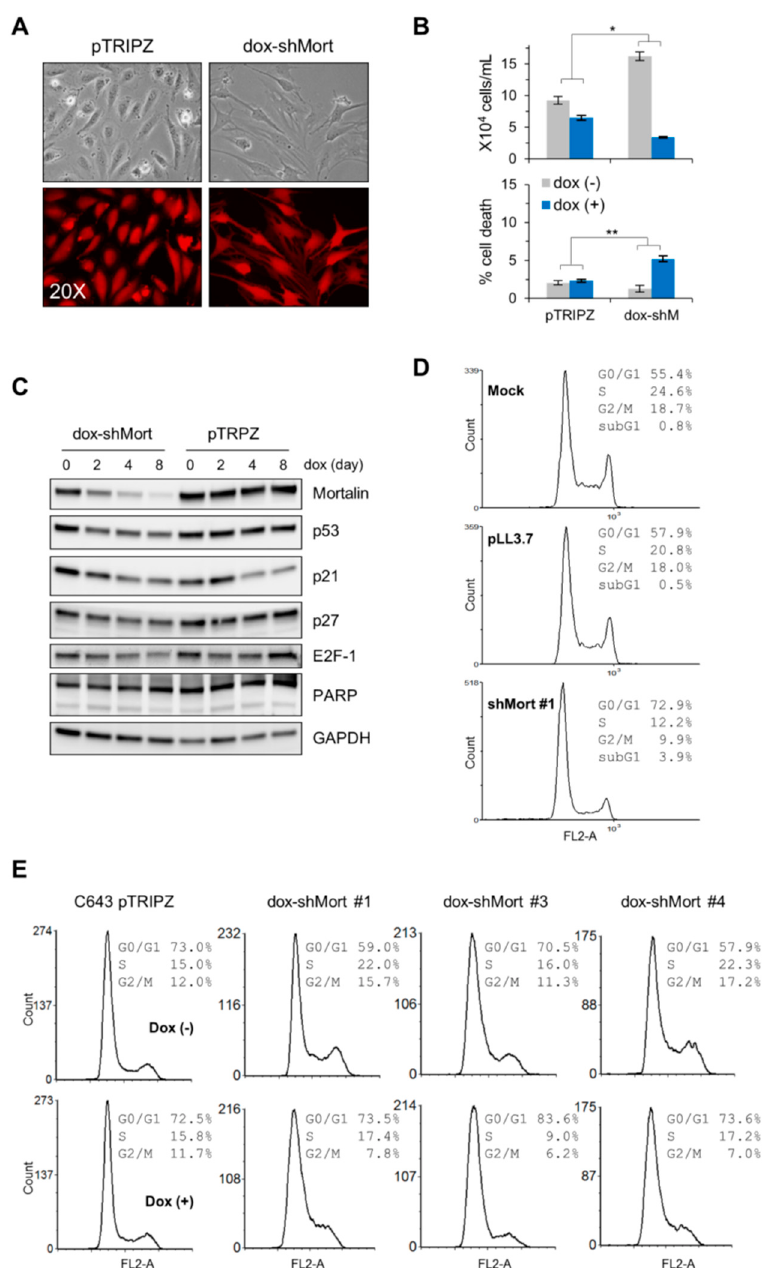
Figure 3. Mortalin knockdown induces growth inhibition in the ATC cell line, C643. ( A – C ) C643 cells were infected with the lentiviral pTRIPZ-dox-shMort or the empty pTRIPZ. ( A ) Dox-induced RFP expression indicates infection e ffi cacy. ( B ) Trypan blue exclusion analysis of live and dead cells at dox treatment day 8 (mean ± SD, n = 3), * p < 0.05; ** p < 0.005. ( C ) Western blot analyses of total cell lysates harvested at indicated dox treatment days. GAPDH is the control for equal amounts of protein loading. ( D ) Cell cycle analysis of C643 cells infected for 4 days with the lentiviral pLL3.7 expressing shRNA that targets mortalin mRNA (shMort #1). shMort#1 and pTRIPZ-dox-shMort target di ff erent regions of mortalin mRNA. Uninfected (mock)- or empty virus-infected cells were used for comparison. Knockdown e ffi ciency is shown in Supplemental Figure S2. ( E ) Cell cycle analysis of di ff erent clones of C643 stably infected with pTRIPZ-dox-shMort (#1, #3, and #4) after 8 day dox treatment. Western blot data of these clones are shown in Supplemental Figure 3. Contrary to C643 cells, the ATC cell line 8505C exhibited different cell cycle profiles in response to mortalin depletion, although these cells exhibited consistent effects on viability loss (Figures 4,B;